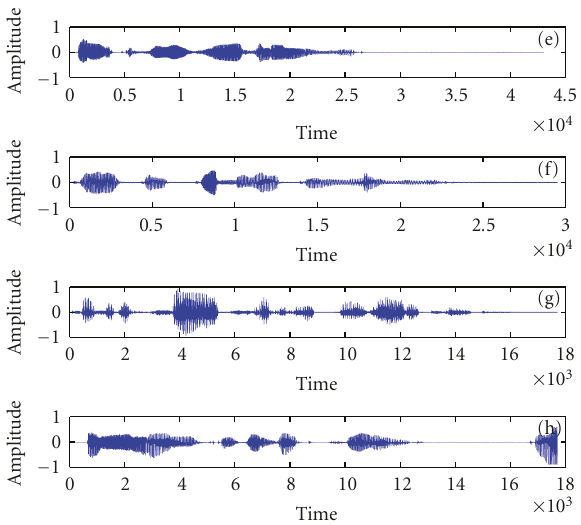
Figure 5: The original signals “e”, “f”, “g”, and “h”.